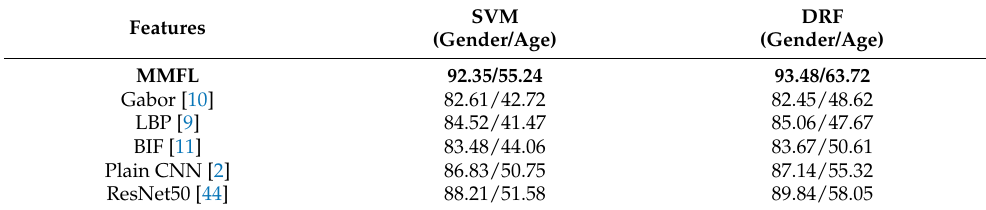
Table 2. Gender and age classification accuracy (%) of SVM/DRF using different image features. Features